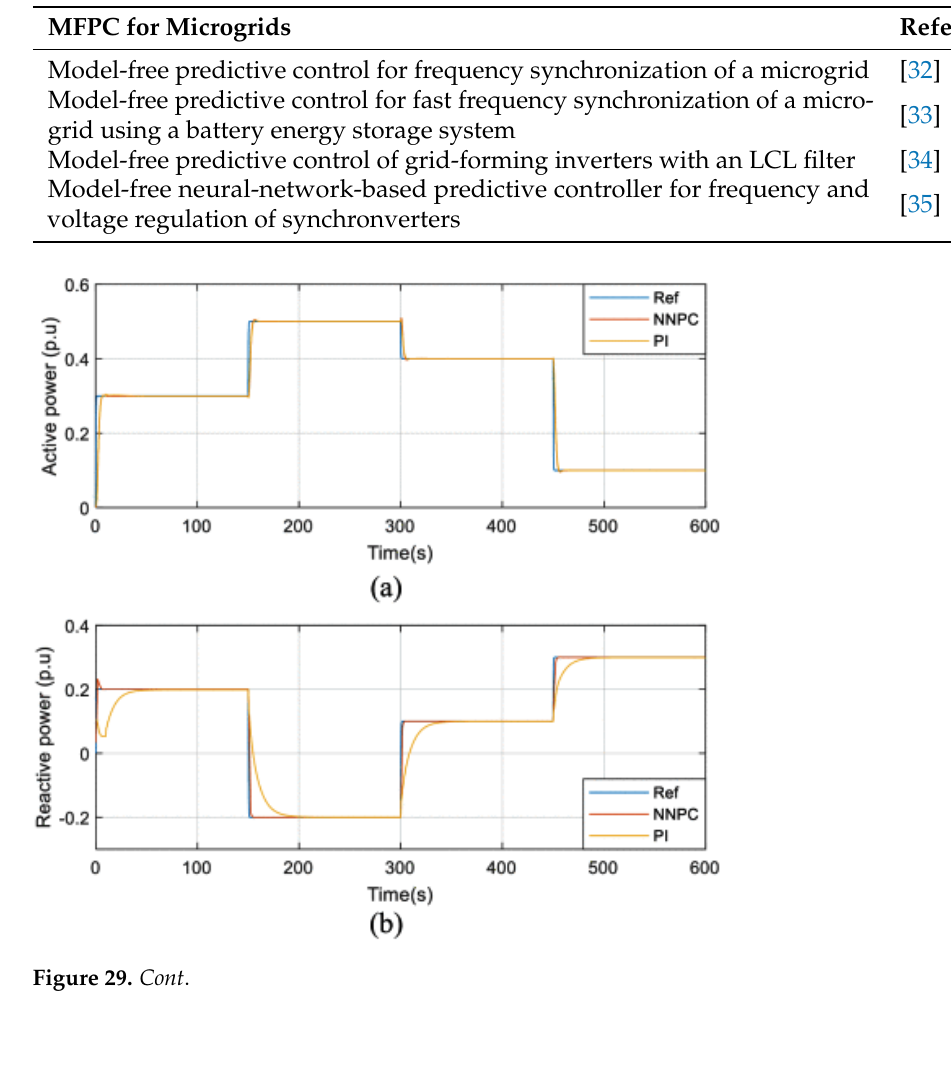
Table 5. Research papers on the application of model-free predictive control in microgrids.